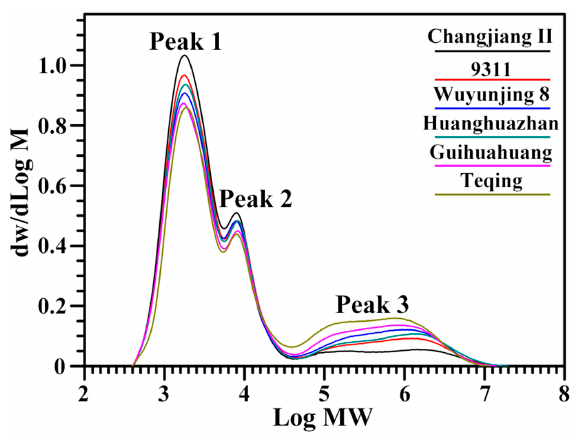
Figure 3. GPC chromatograms of isoamylase-debranched starch .